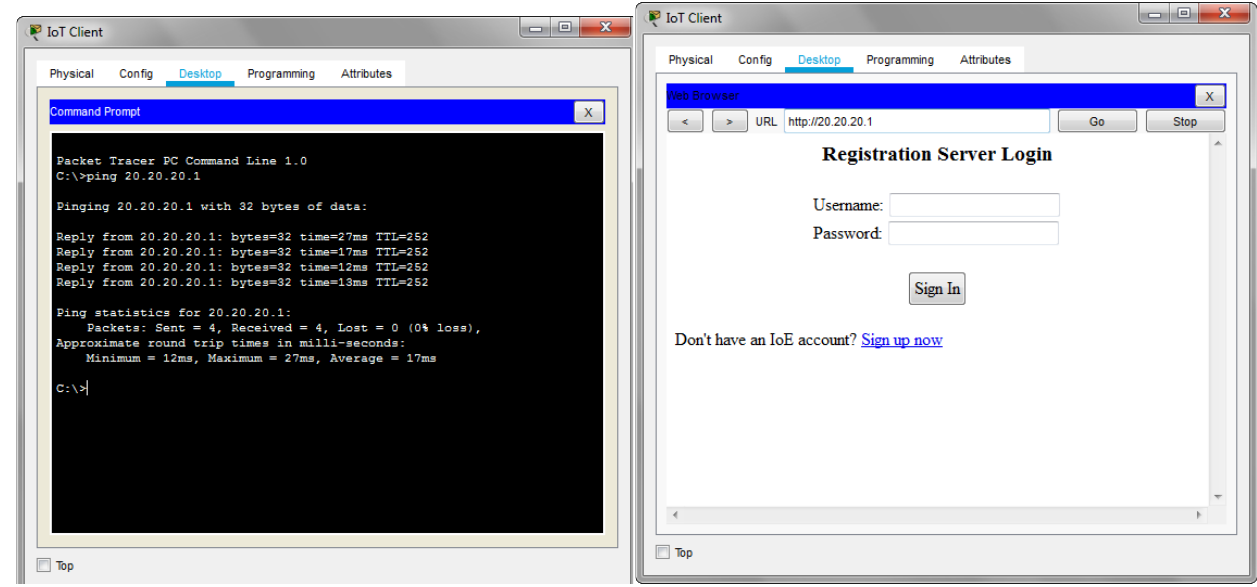
Figure 10. Access from the external network to the IoT server.